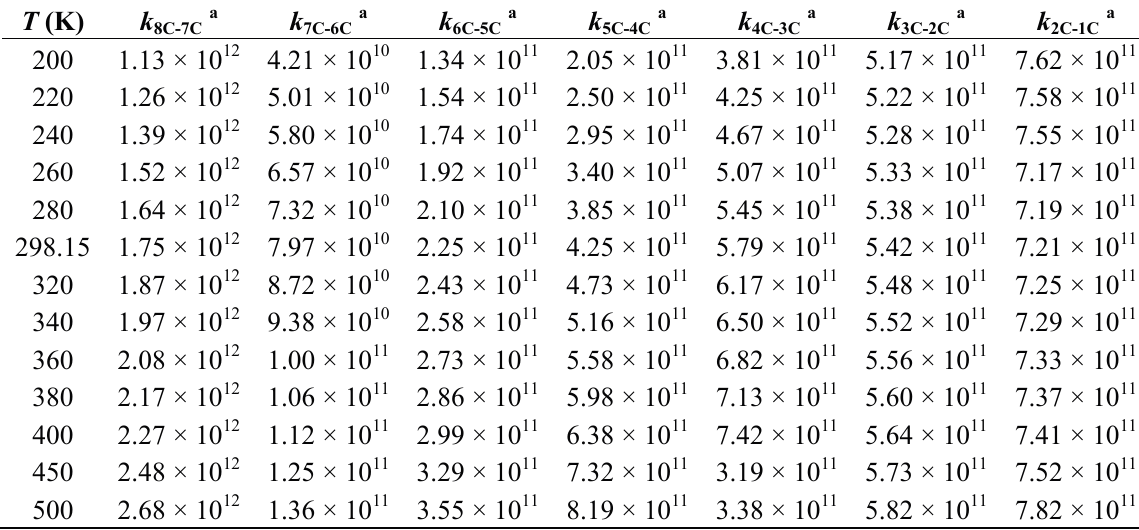
Table 1. The rate constants of decarboxylation reactions (~C of 200–500 K